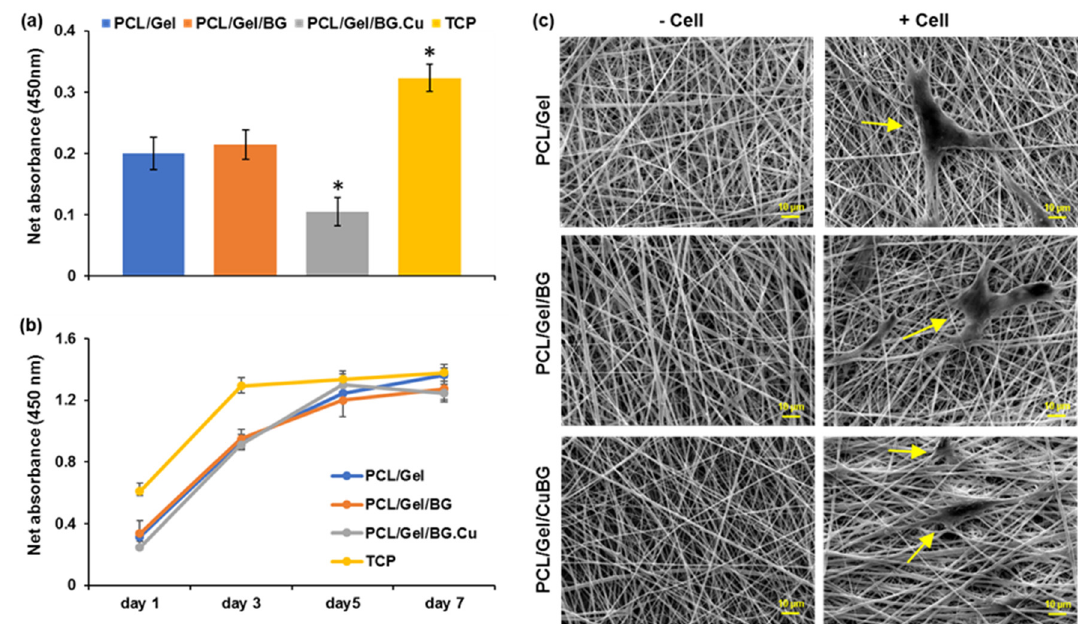
Figure 4. Cellular attachment and proliferation on substrates ( a ) The primary attachment of aBMSCs on the surface of PCL/Gel and PCL/Gel/BG and PCL/Gel/CuBG, as well as TCP as the positive control, measured by MTS assay (* p -value < 0.05) ( b ) The proliferation rate of aBMCSs on the surface of scaffolds and TCP at different time points during a week. All monitored absorbance were normalized to cell-free control of each membrane ( c ) SEM images of three scaffolds after one day. aBMSCs are shown with arrows.